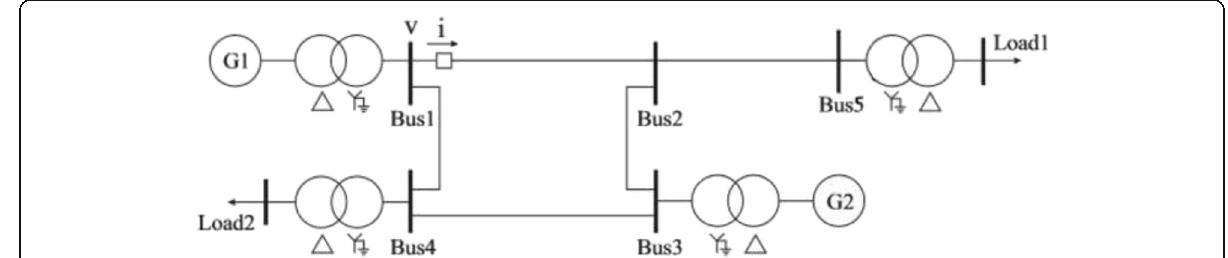
Fig. 1 Schematic diagram of the power system under study